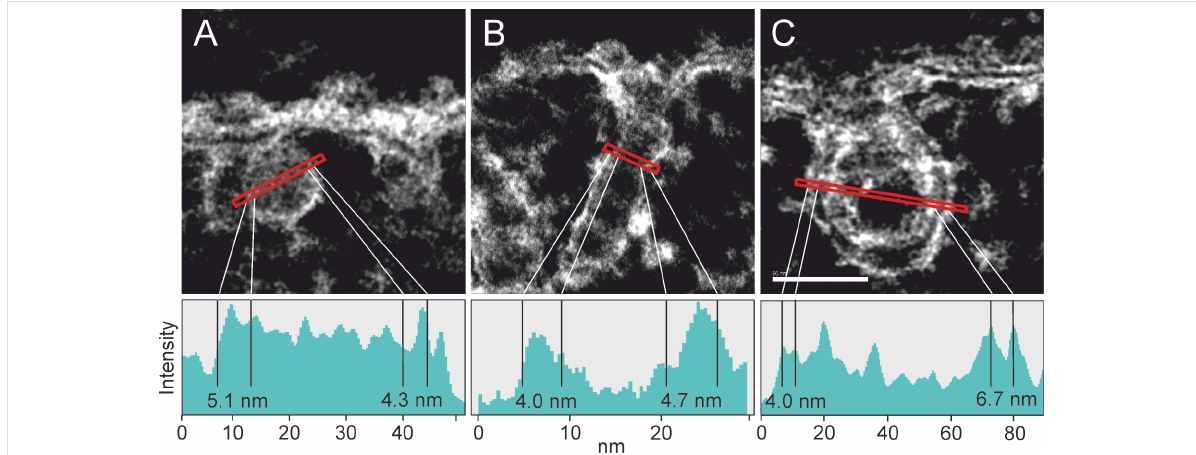
Figure 5: STEM micrographs showing the particle surrounding membrane formed upon uptake of SiNP-22 (A), SiNP-12 (B) and SiNP-7 (C), respec- tively. The thickness of the membrane is measured from the intensity profile (below). Membrane thickness varies little and is found to be between 4 and 7 nm for all three different particle sizes. For SiNP-22 and SiNP-12 the typical contrast characteristic for a double layer membrane is unincisive as can be seen in the respective intensity profiles. Experimental conditions same as in Figure 4. Scale bar = 50 nm.